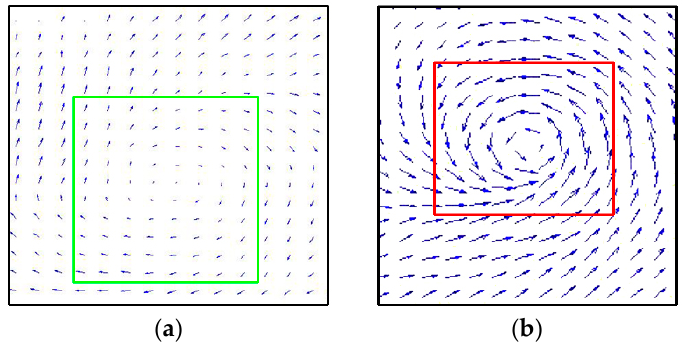
Figure 1. Examples of classified wind fields in the dataset: ( a ) green box represents Class 1 (clockwise cyclone); ( b ) red box represents Class 2 (anticlockwise cyclone). Both of the examples are selected from the northern hemisphere.